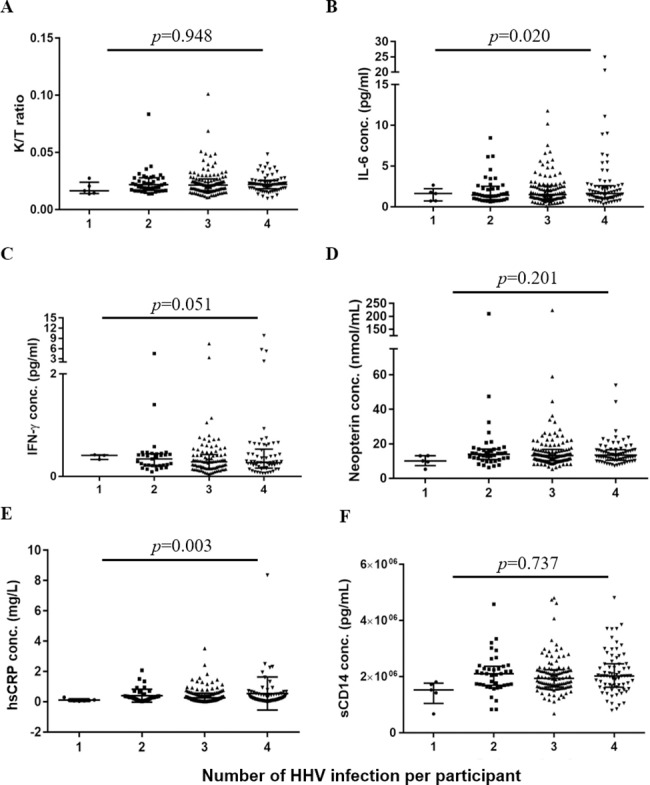
Comparisons in K/T ratio (A), IL-6 (B), IFN-γ (C), neopterin (D), hsCRP (E) and sCD14 (F) in groups with increasing number of HHV co-infections. The p-values indicate statistical significance following Poisson regression modelling, adjusted for age, gender and ethnicity. The error bars indicate the median(IQR) for each group. The numbers in the x-axis indicate the total number of HHV co-infections per participant. *Significance at p<0.05.